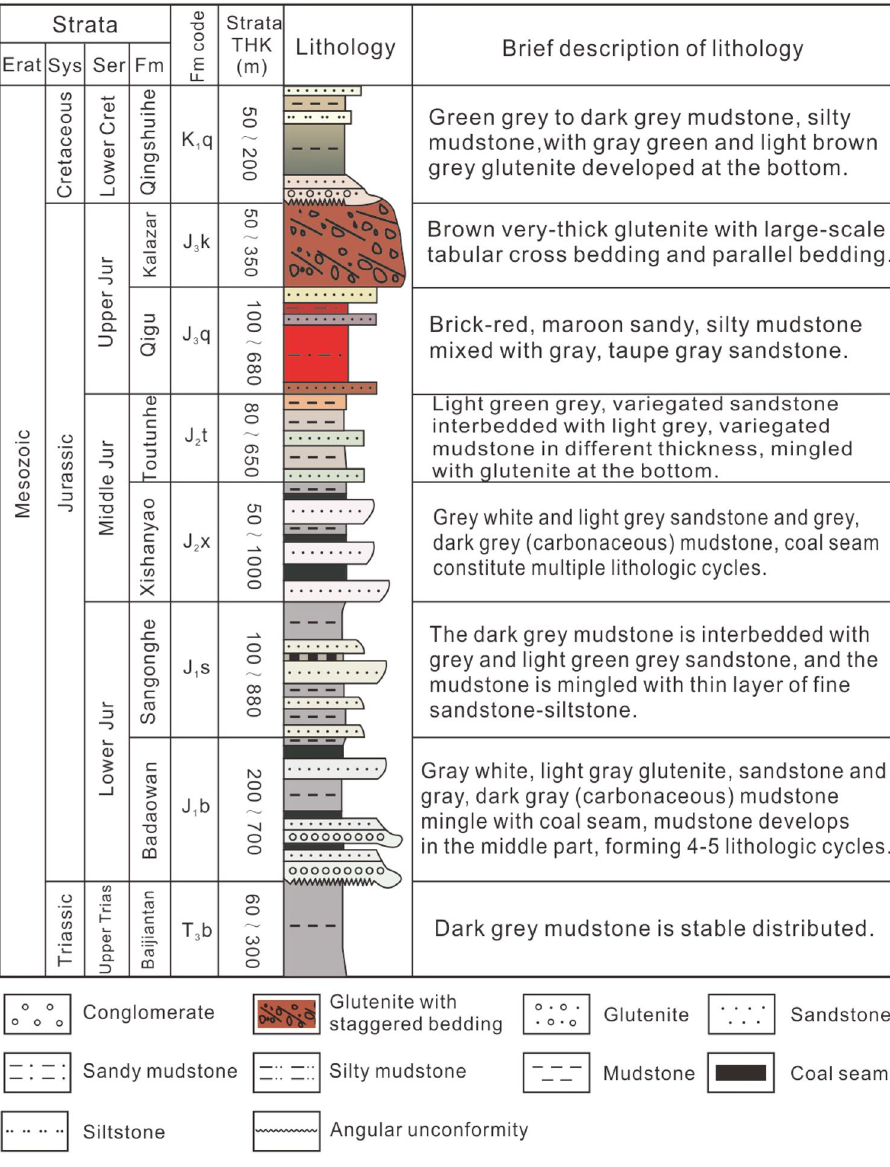
Fig. 2 Comprehensive